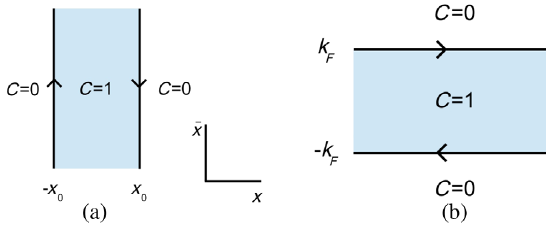
FIG. 1. Phase-space realization of (a) real-space edges and (b) Fermi points for a 1D real-space system. Arrows indicate the direction of the edge